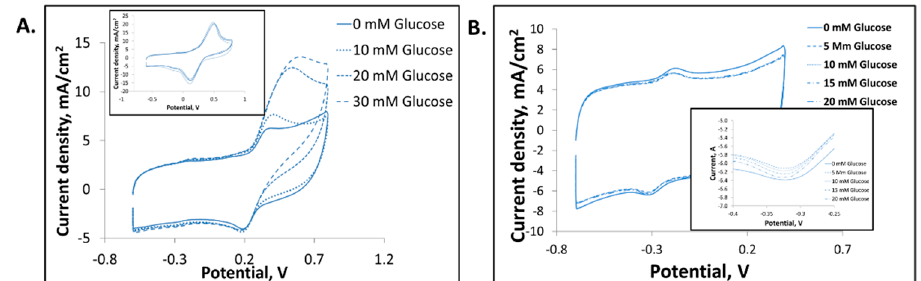
Figure 4. Cyclic voltammetry in oxygen-free PBS solution of LDG-CH10 bioelectrode using increasing glucose concentrations ( A ) in the presence of HQ 2 mM (inset: bare graphite rod) and ( B ) in the presence of the inhibitor Ag + 1 µM. Voltammograms acquired at 0.1 V/s.